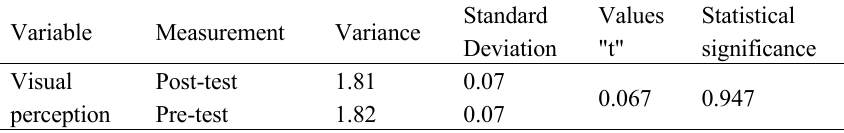
Test results of Paired sample T Test to detect differences between the averages among the members of the experimental group in their visual perception after multiple senses strategy